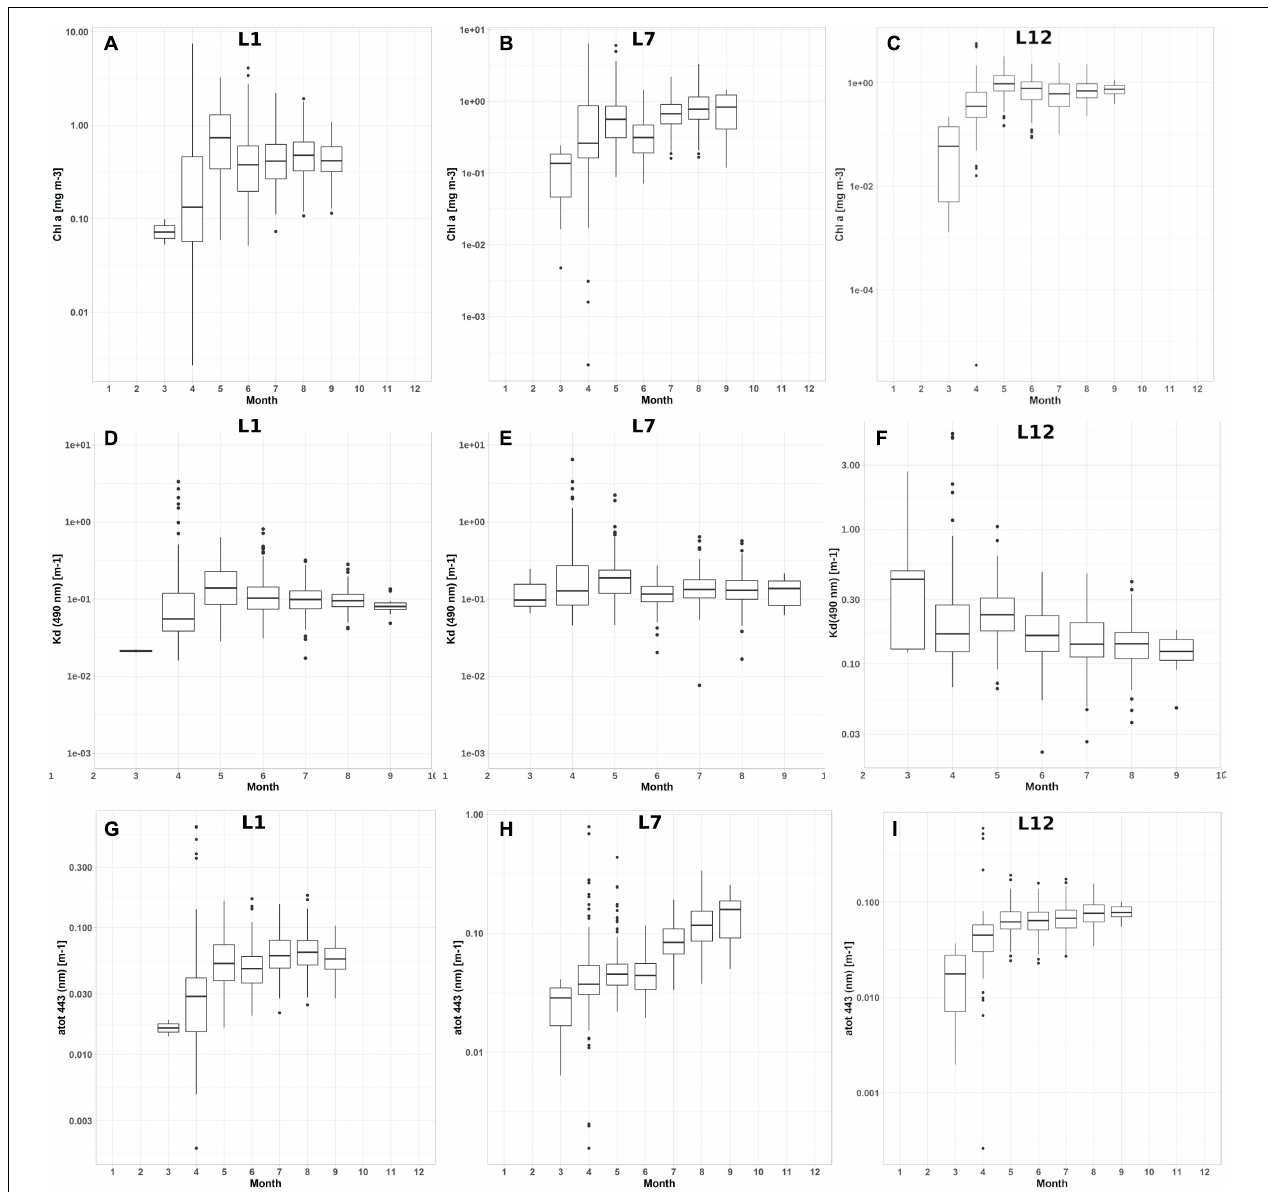
FIGURE 3 | Distribution of the Chla (A–C) , K d (490) (D–F) , and a tot (443 nm) (G–I) in each month for the whole data series 1997 – 2019 at locations: L1 (on the shelf near the entrance to the Kongsfjorden) (A,D,G) – 1st column, L7 (in the central Isfjorden) (B,E,H) – 2nd column and L12 (in the outer Hornsund fjord) (C,F,I) – 3rd